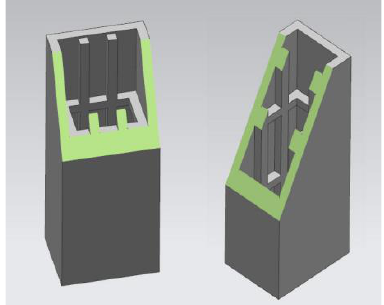
Figure 4. Arrangement of inner reinforcing plate inside the column structure.